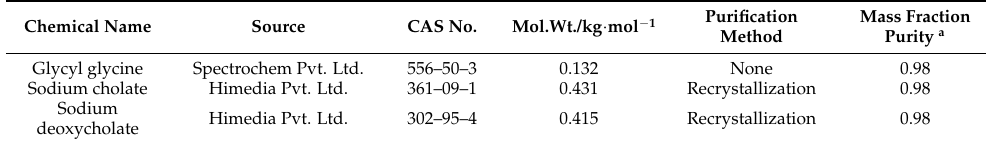
Table 6. Specification of chemicals